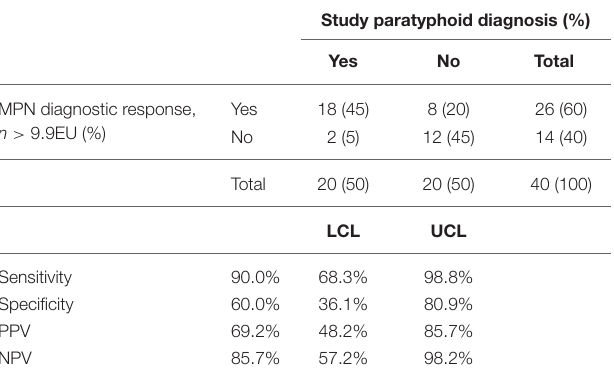
TABLE 4 | Performance of anti-MPN IgA ALS responses as a serodiagnostic test compared to the study paratyphoid diagnosis definition (fever and/or bacteremia). Study paratyphoid diagnosis (%)